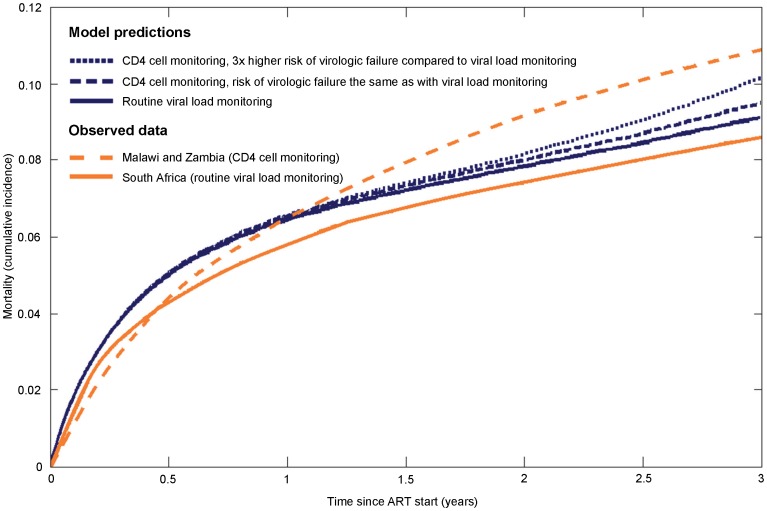
Comparison of all-cause mortality based on model predictions and observed data.Orange lines show Kaplan-Meier estimates from ART programmes in South Africa, Malawi and Zambia [12] and blue lines the model predictions. Solid lines represent routine viral load monitoring (South Africa) and broken lines CD4 cell monitoring (Malawi, Zambia).